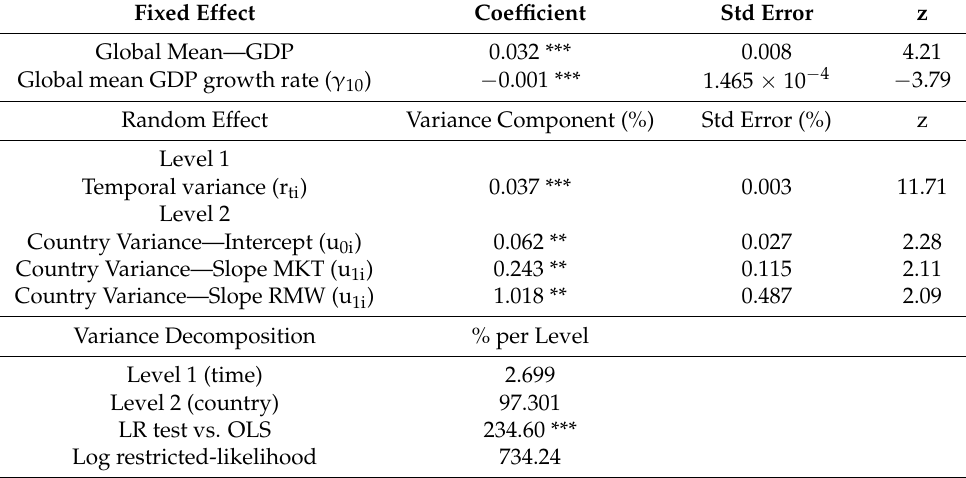
Table 10. Decomposition of Variance—Linear Trend Model with Random Intercepts Without the Risk Factors MKT and RMW in the Fixed Effects Component, yet, with Random Slopes in the Temporal